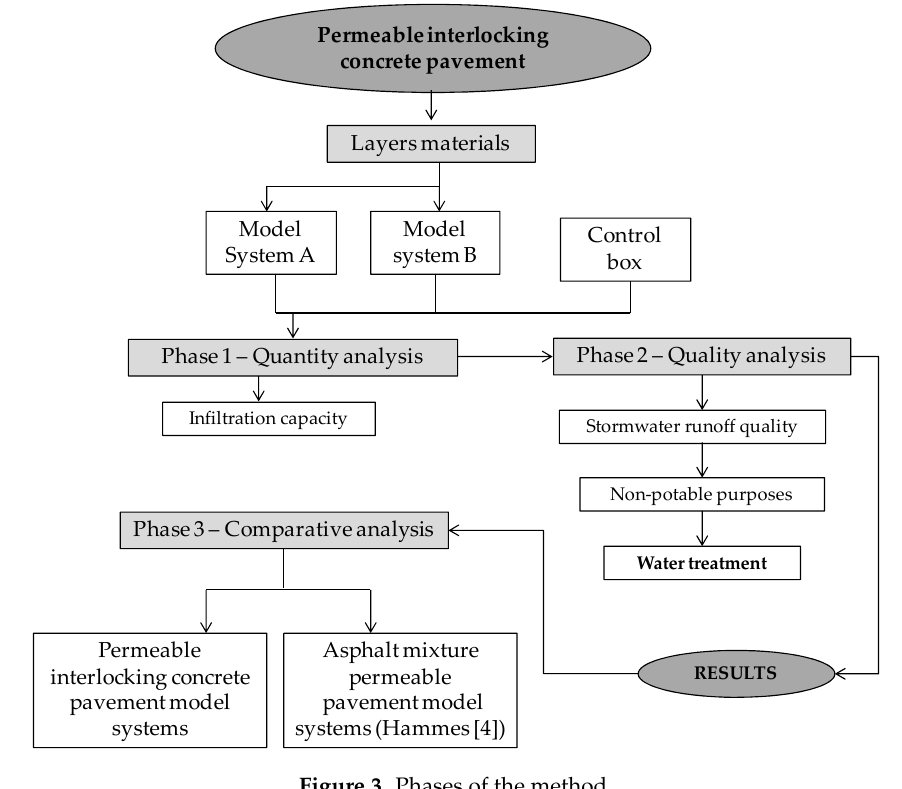
Figure 3. Phases of the method.